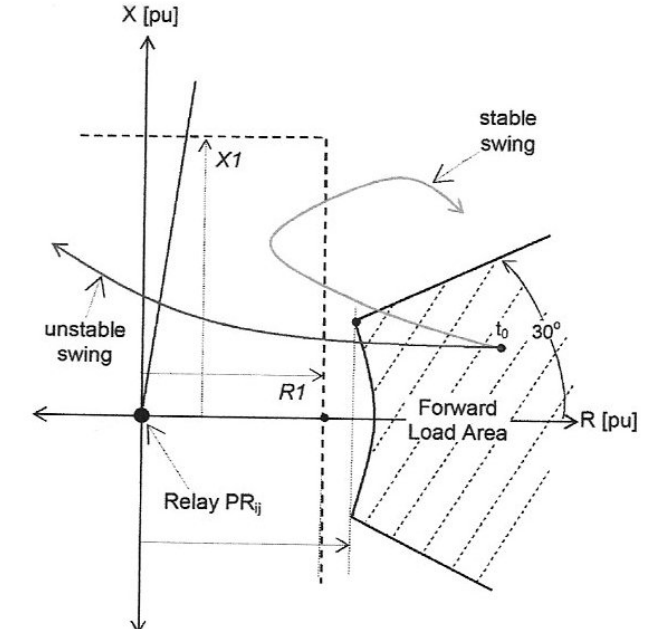
Figure 5. Trajectory of the apparent impedance seen by the relay PRij of the ASI on bus i. Symbols are: R1 (resistance of zone-1 setting), X1 (reactance of zone-1 setting), and t (pre-disturbance